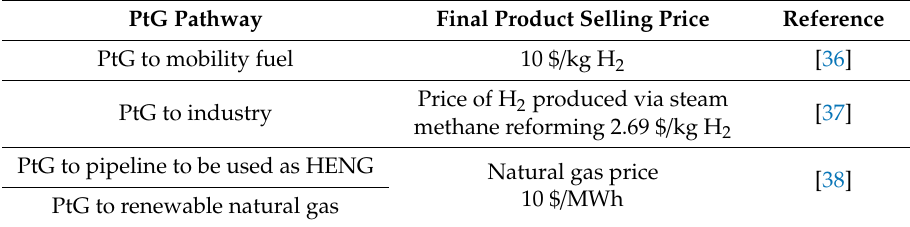
Table 3. Final product selling price for each PtG pathway